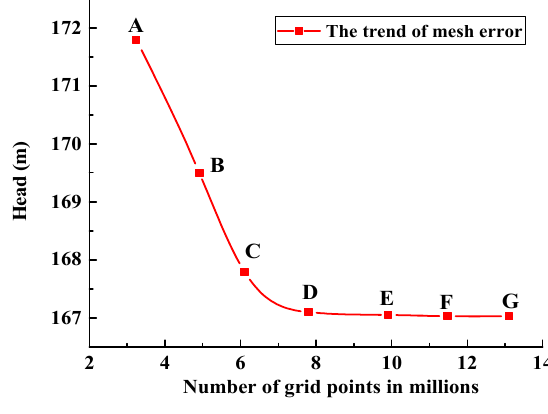
Figure 4. The trend of mesh error.